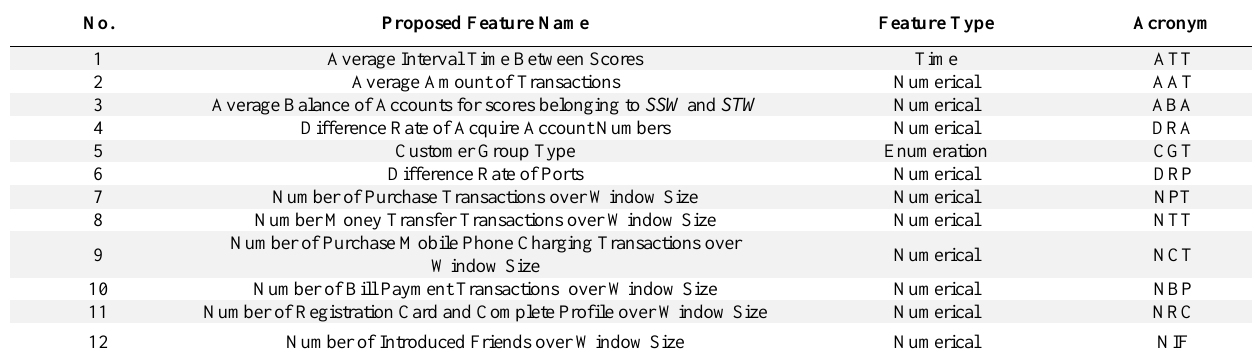
Table 2. Features proposed for a sliding window-based feature